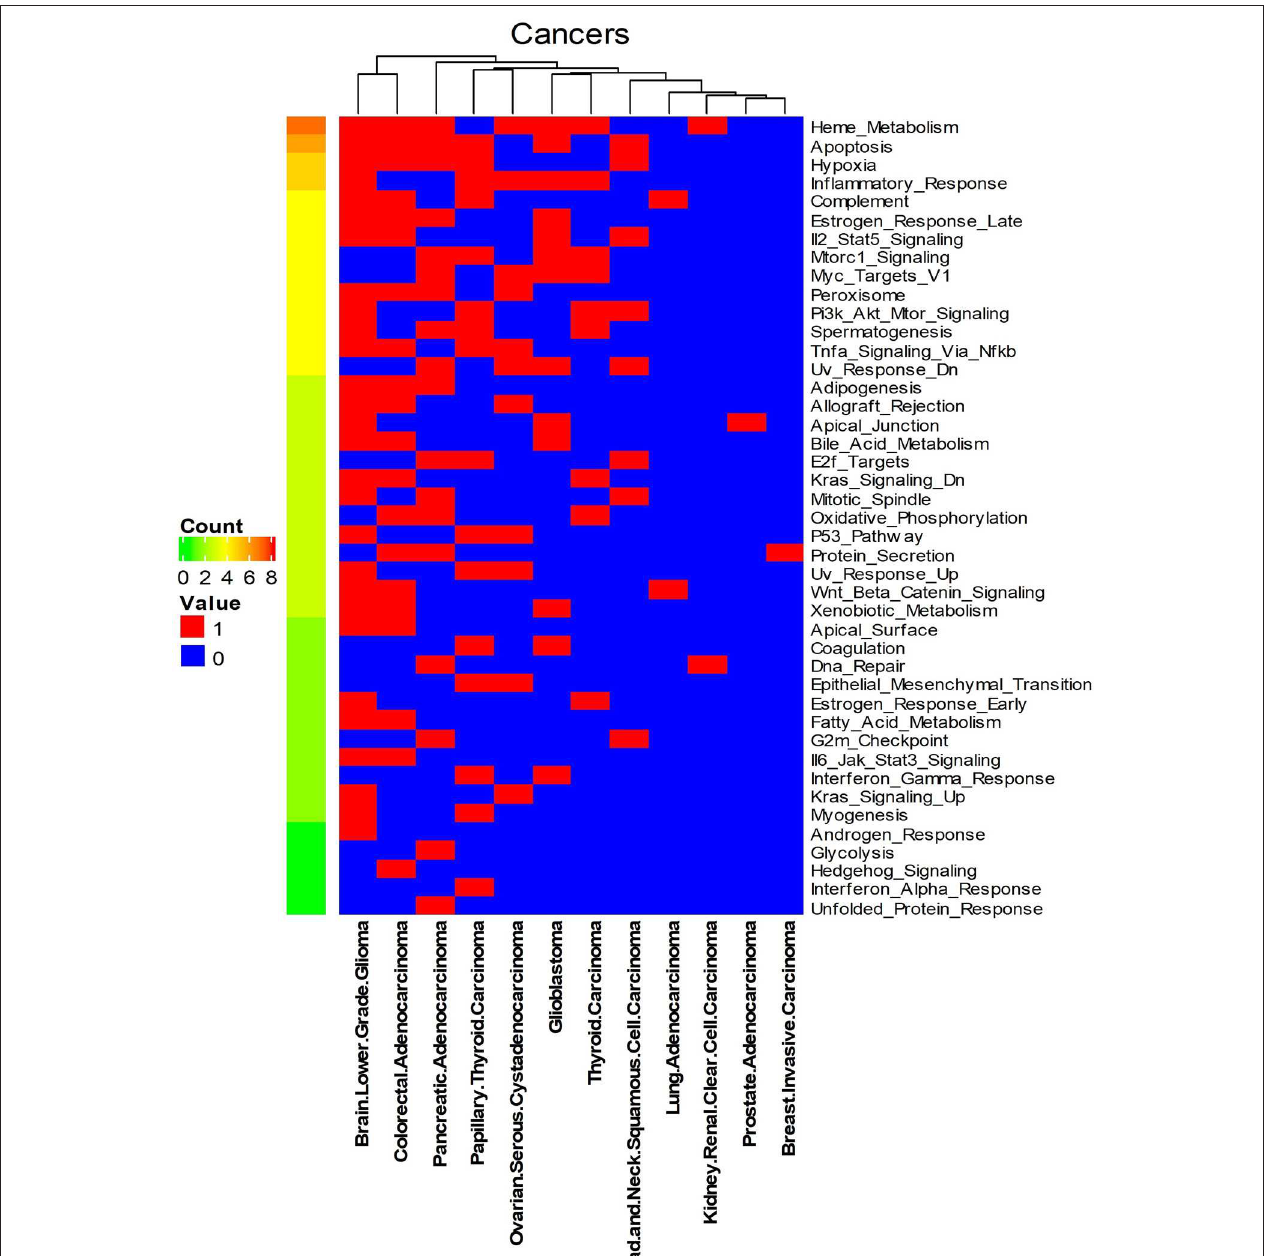
FIGURE 4 | Enriched GSEA hallmark gene sets of all the biomarker gene sets of all the 12 cancer types. Names on the right Y-axis are the hallmark gene sets. Names on the bottom X-axis are the names of the 12 cancer types. Count means the number of cancers whose significant gene sets enriched in corresponding hallmark gene sets. Values in this figure are 0 or 1. Zero means the biomarker gene sets of the corresponding cancer are not enriched in the hallmark gene sets.